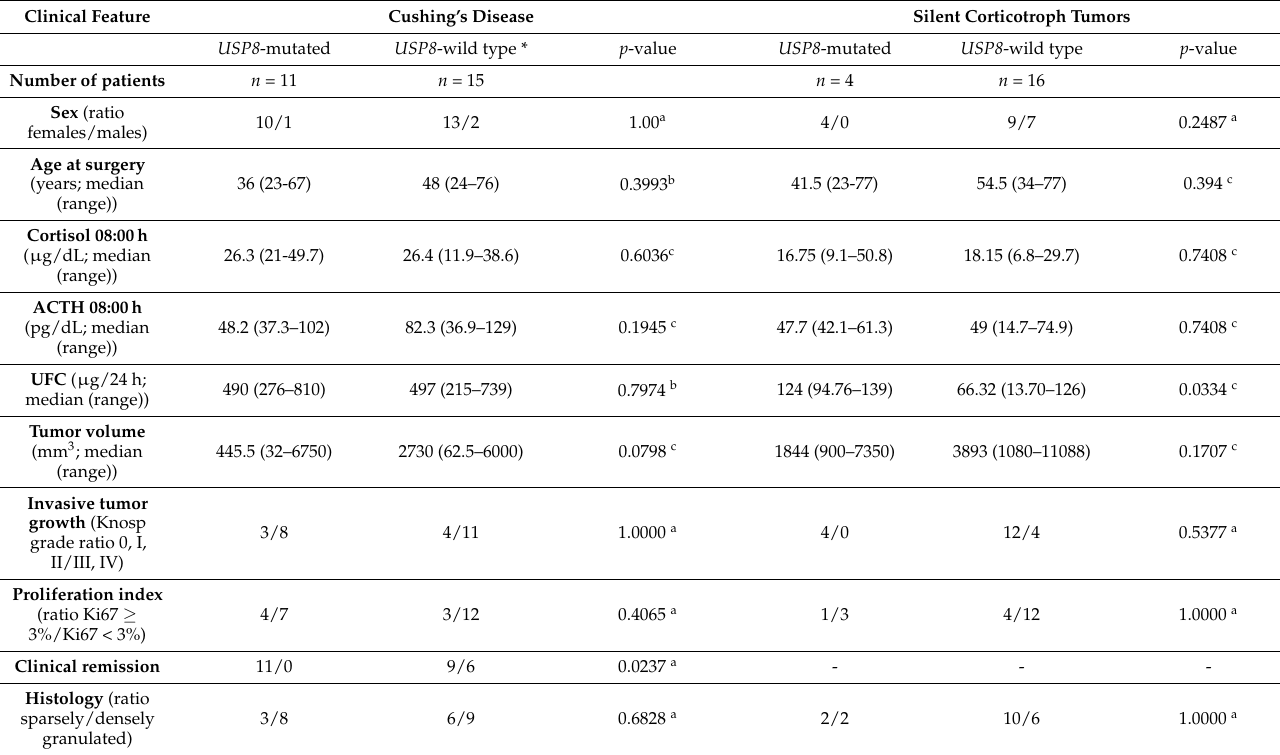
Table 2. Summary of clinical features in patients with Cushing’s disease and silent corticotroph tumors regarding USP8 mutation